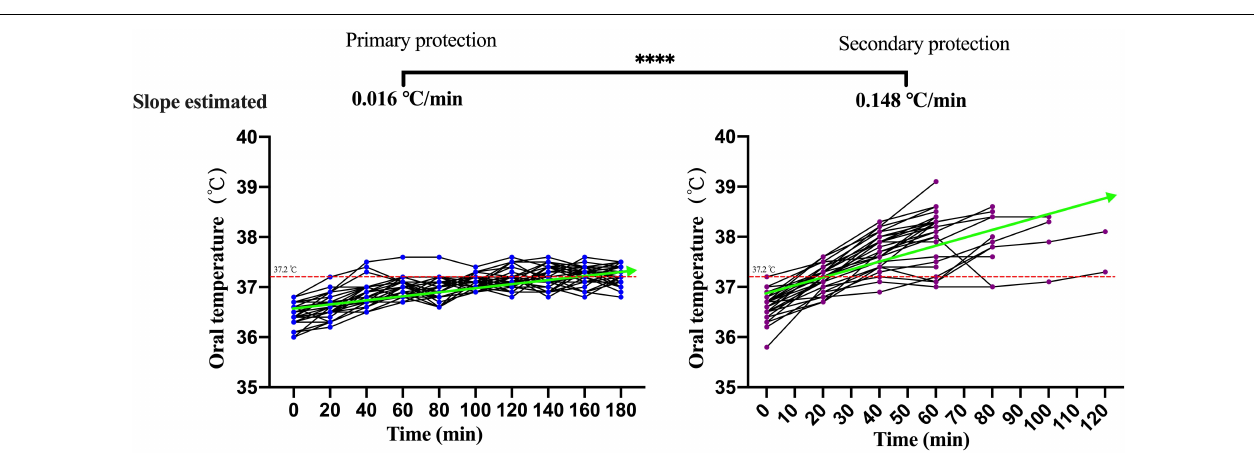
FIGURE 3 | The dynamics of oral temperature of participants with primary and secondary PPE. ∗∗∗∗ p < 0.0001. The slopes of oral temperature during the trial were calculated by generalized estimating equations. PPE, personal protective equipment.